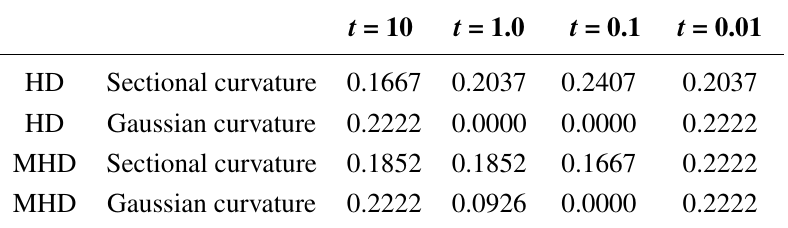
Table 2. Rand index vs. t for COIL